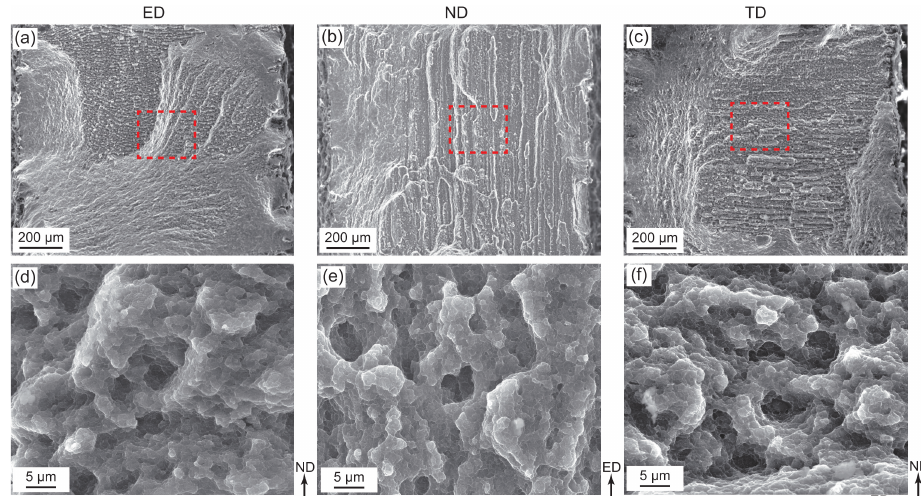
Figure 10. SEM fractographs of the postmortem specimens for quasi-static tensile loading along the ( a ) ED, ( b ) ND and ( c ) TD. ( d – f ) are magnified views of the regions indicated by the rectangles in ( a – c ),